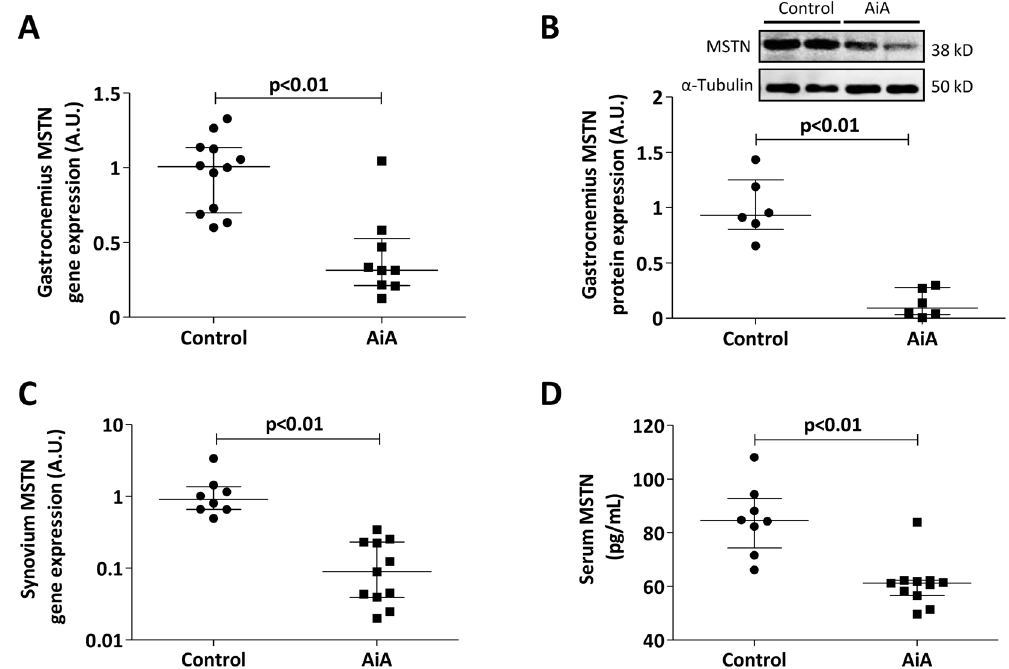
Figure 6. Local and systemic myostatin levels in skeletal muscle, synovium and serum. ( A ) Myostatin gene expression in gastrocnemius from control and AiA rabbits (n = 6 rabbits per group, both limbs of each rabbit are represented). ( B ) Myostatin protein expression in gastrocnemius from control and AiA rabbits. Data for protein expression are expressed as arbitrary densitometric units (A.U.) and normalized relative to the expression of α -tubulin (n = 6 rabbits per group). Representative cropped blot of two animals of each group are shown, control and AiA, respectively. Full length blot is presented in Supplementary Figure 1. ( C ) Myostatin gene expression in the synovium. ( D ) Serum myostatin levels in control and AiA rabbits. MSTN = Myostatin. Graphs show individual values and medians with IQRs are also indicated (n = 8–11 rabbits per